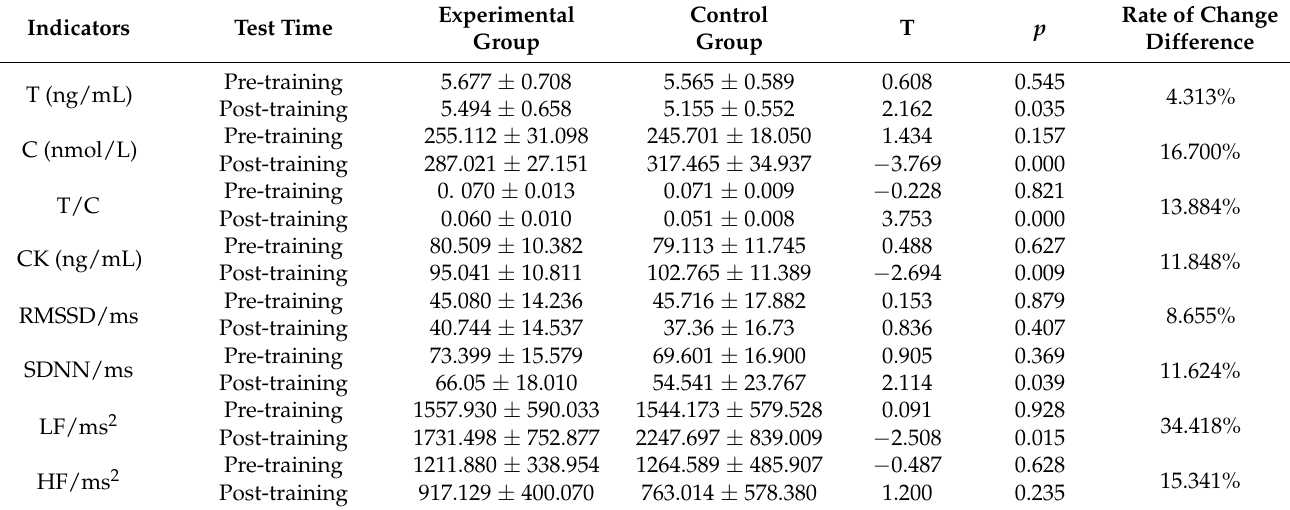
Table 4. Analysis of blood markers and HRV results before and after tPCS intervention in the two groups.